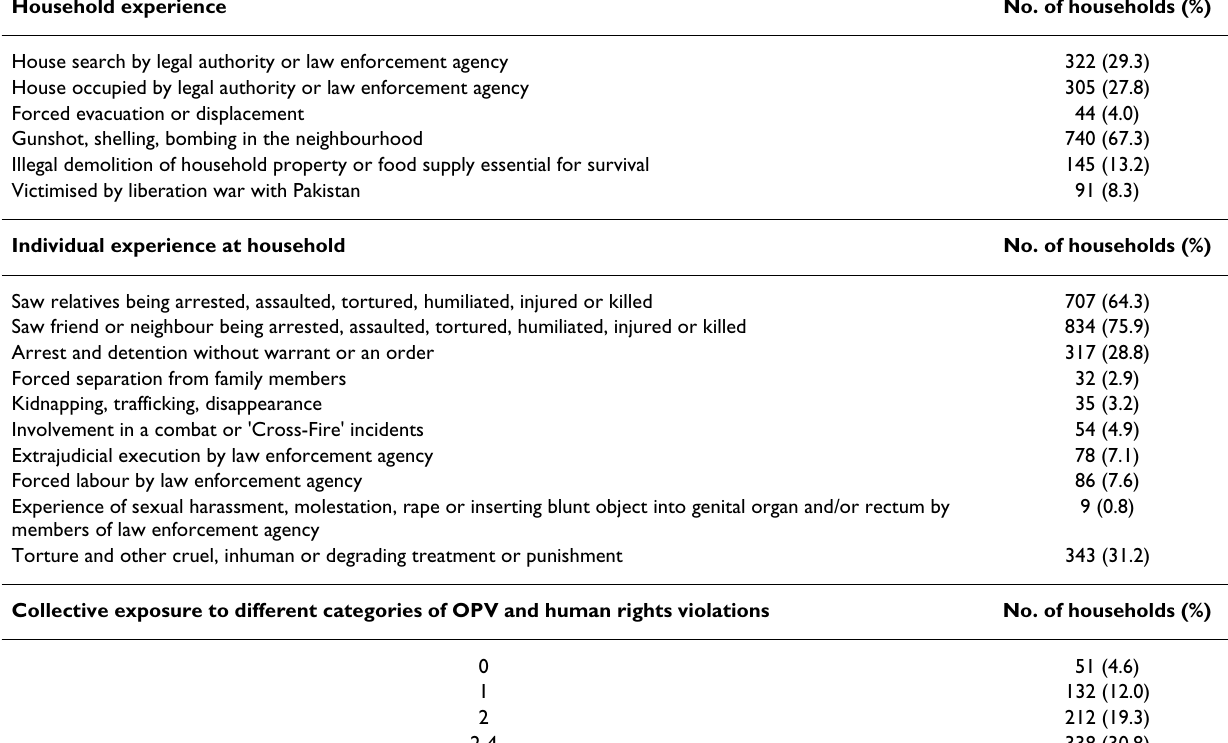
Table 3: Prevalence of organised crime and political violence (OPV) and human rights violations Household